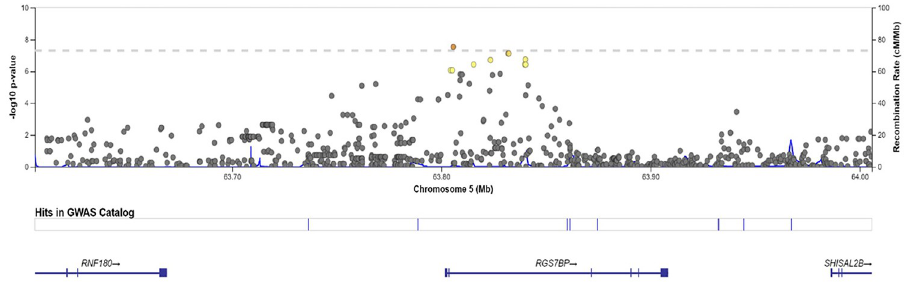
Fig 3. LocusZoom plot for region surrounding rs1848553. The LocusZoom plot shows the region surrounding rs1848553 on chromosome 5, using an LD panel and reference genome from the AFR super-population in the 1000G project. Yellow and orange indicate higher levels of LD.